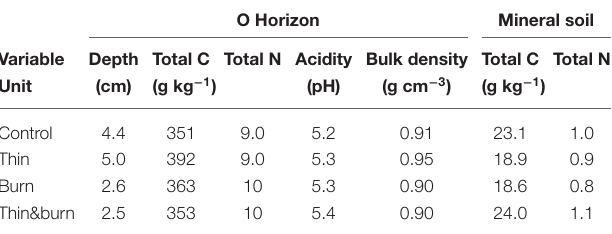
TABLE 1 | Soil physical and chemical characteristics (mean) on plots at the Fire and Fire Surrogates study site at Lubrecht Experimental Forest (see Gundale et al.,